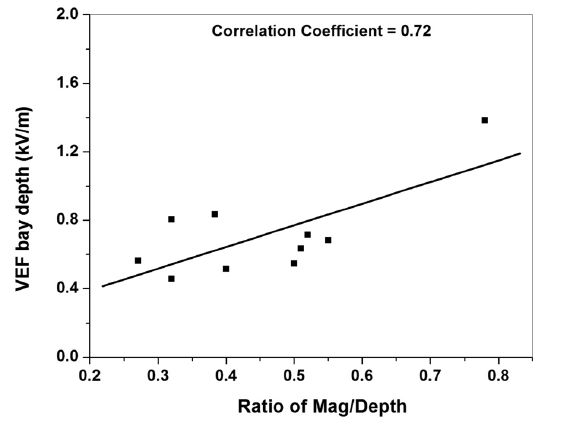
Figure 4. Correlation plot between the ratio of magnitude to depth and the VEF bay depth.